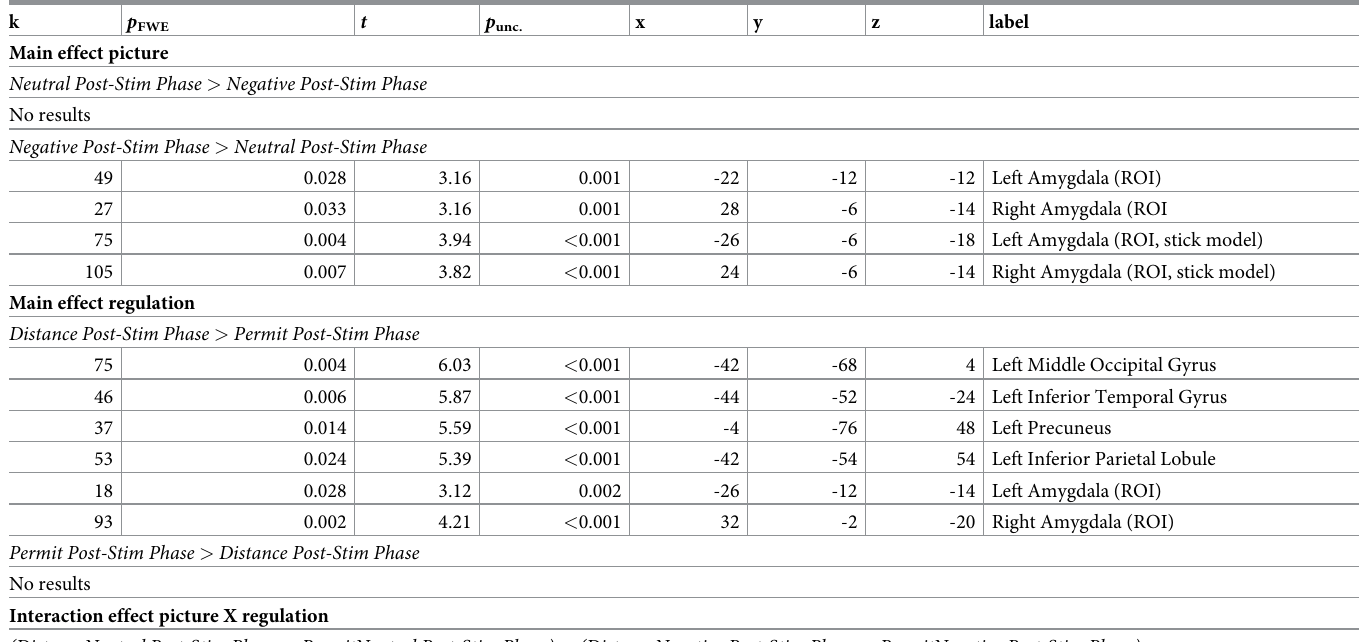
Table 2. Activation maxima in the emotion regulation task during the post-stimulation phase (immediate effects, timepoint